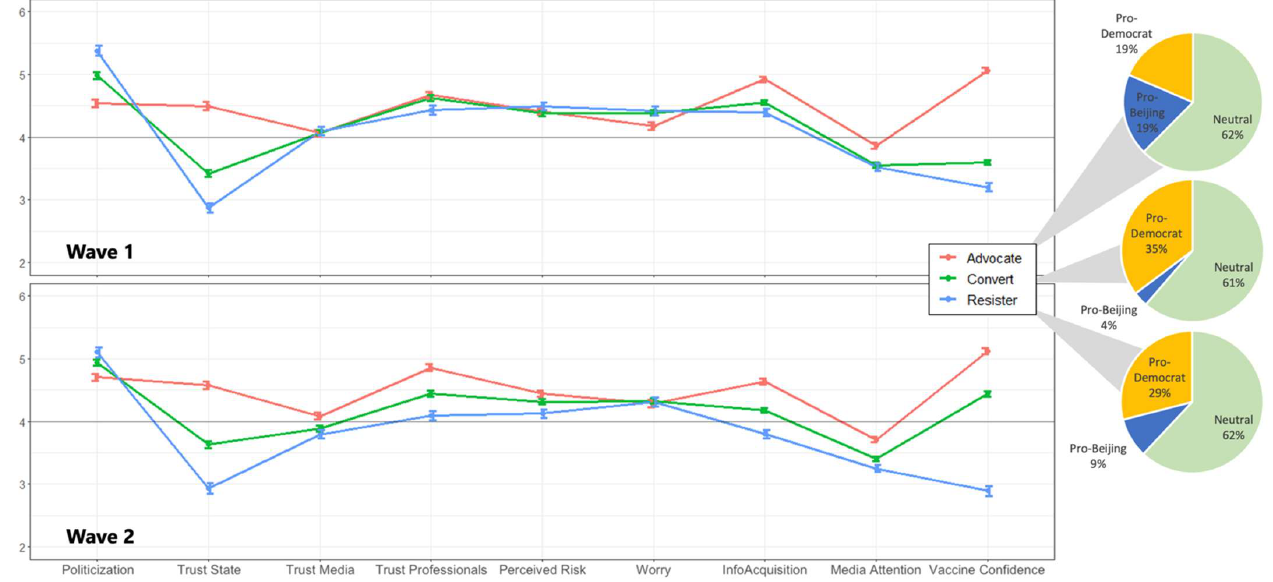
Figure 3. Unadjusted means and bootstrapped standard error for all variables used in the MLR for the three vaccine profiles. All variables were measured in a 7-point Likert scale with 1 = strongly disagree, 4 = neutral, and 7 = strongly agree. The pie charts show the distribution of political orientation within each profile. Compared to other groups, Vaccine advocates comprised more pro-Beijing (19%) individuals, while vaccine resisters were more pro-democracy (35%). Table 3. Psychological indicators of vaccine advocates, resisters, and converts. Group Comparisons Total Vaccine Advocate a Vaccine Resister b